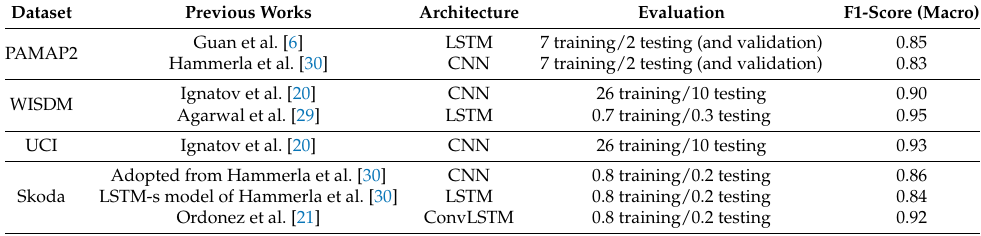
Table 1. Dataset, architectures, and macro f1-scores of the previous works forming our baselines.